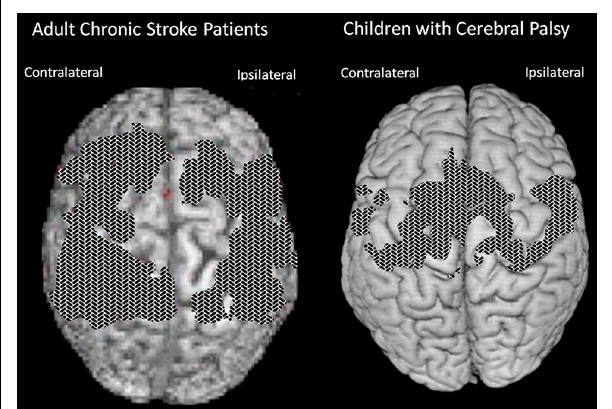
FIGURE 3 | Cortical surface-rendered image of gray matter pre- to post-treatment change after CI therapy in (A) adults with chronic stroke and (B) children with hemiparetic cerebral palsy. Gray matter increases displayed on a standard brain. Surface rendering was performed with a depth of 20 mm. Cross-hatched areas indicate t statistics ranging from 2.0 to 6.7, corrected for family-wise error. Panel (A) adapted from Gauthier etal. (2008); panel (B) adapted from Sterling etal.